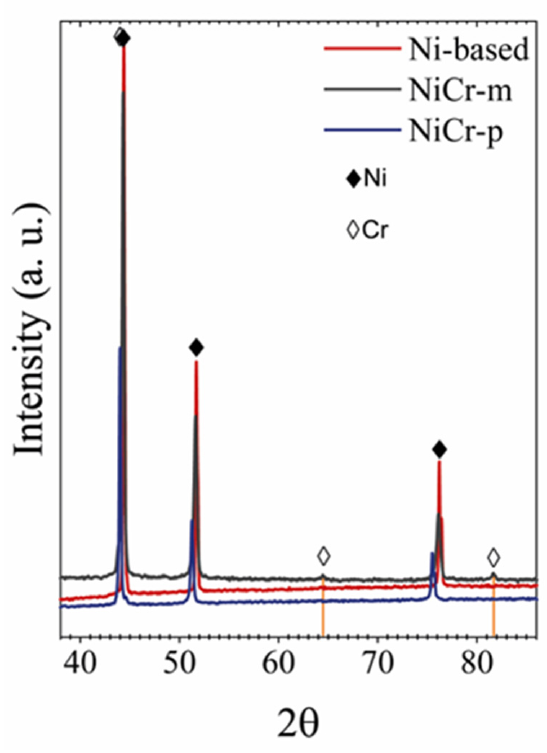
Figure 4. XRD pattern of Ni-based, NiCr-m, and NiCr-p electrodes.